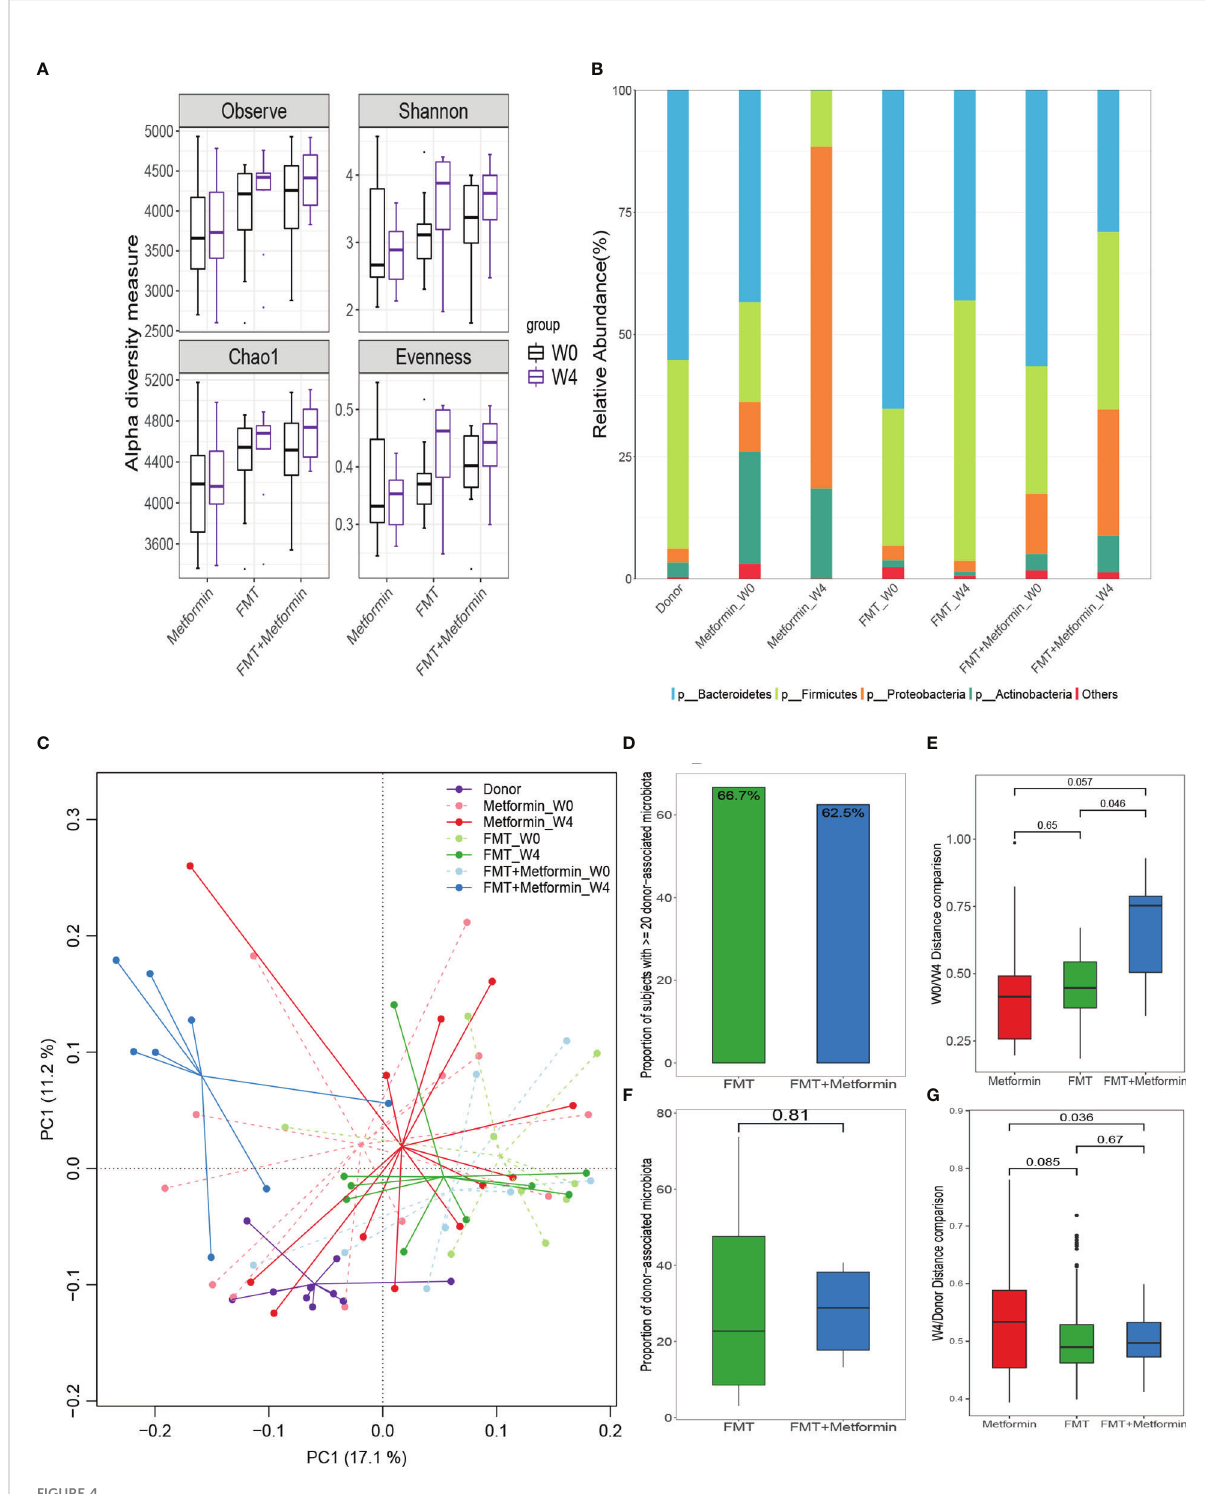
FIGURE 4 Changes in gut microbiota between week 0 and week 4 in T2DM patients after interventions. (A) Differences in alpha diversity indexes, microbial richness (Observed index and Chao1 index), Shannon diversity, and evenness. (B) Relative abundances of the top phyla in the these groups; Changes in gut microbiota and microbial colonization of donor-derived microbiota in subjects with type 2 diabetes. (C) Differences in beta diversity between baseline (W0) and week 4 (W4) after intervention by metformin, FMT, or FMT plus metformin, visualized by PCA. (D, F) The colonization of donor-derived microbiota in FMT alone and FMT plus metformin groups. (E) Changes of Euclidean distance between W0 and W4. (G) Changes of Euclidean distance between W4 and